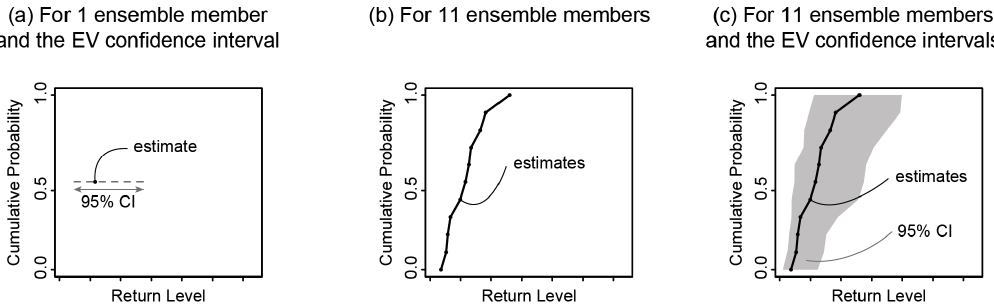
Figure 2. ( a ) Uncertainty related to the EV model parameters: return level estimate (black dot) and its 95% confidence interval (CI, grey dashed line); ( b ) Uncertainty related to the climate model parameters: smoothed empirical CDF of return level estimates for the 11 ensemble members (black line and dots); ( c ) Combined uncertainty related to the EV and climate models: smoothed empirical CDF of return level estimates (black line and dots) and associated 95% CI (grey area) for the 11 ensemble members.